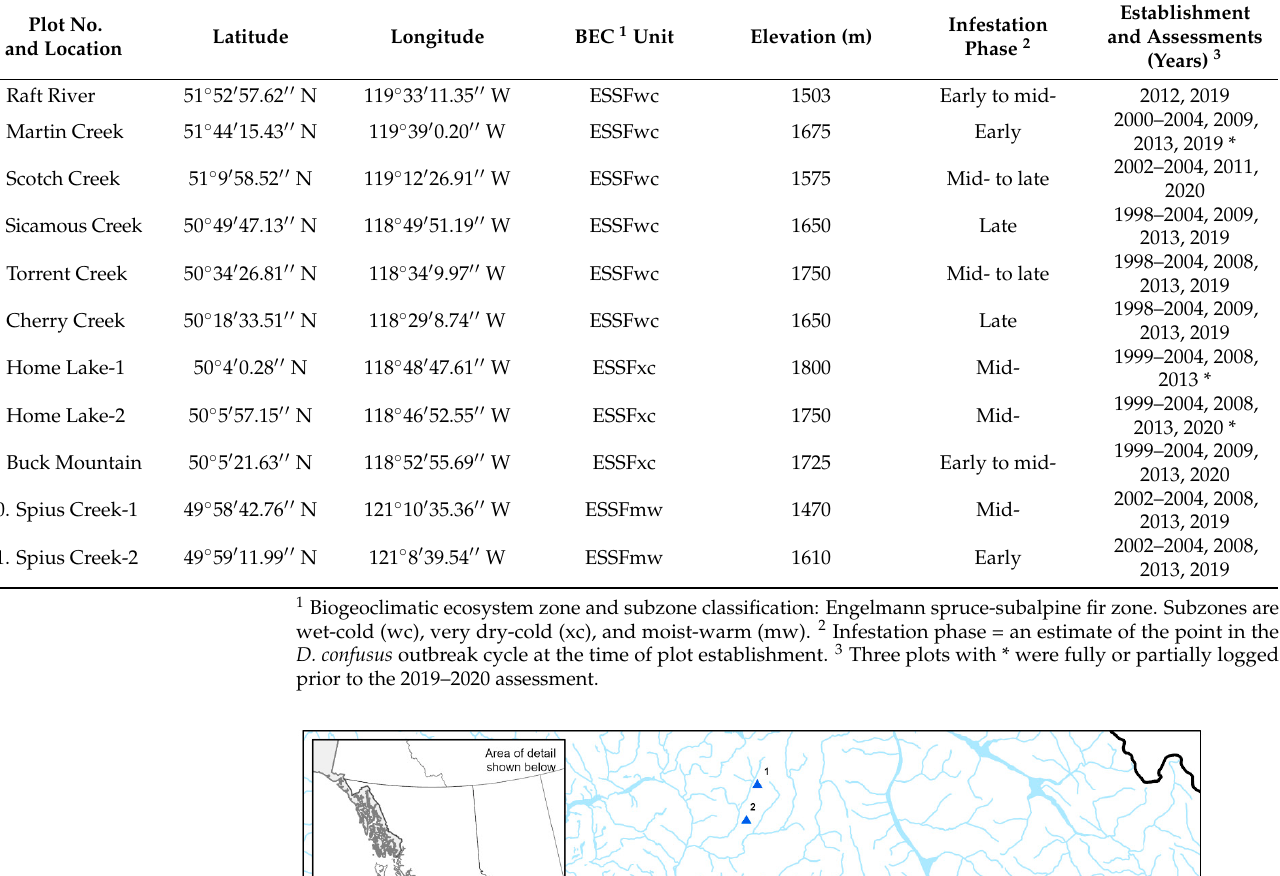
Table 1. Geographic location, latitude, longitude, biogeoclimatic classification, elevation (meters), D. confusus infestation phase, year of establishment, and years of assessment for 11 one-hectare plots in southern interior British Columbia.